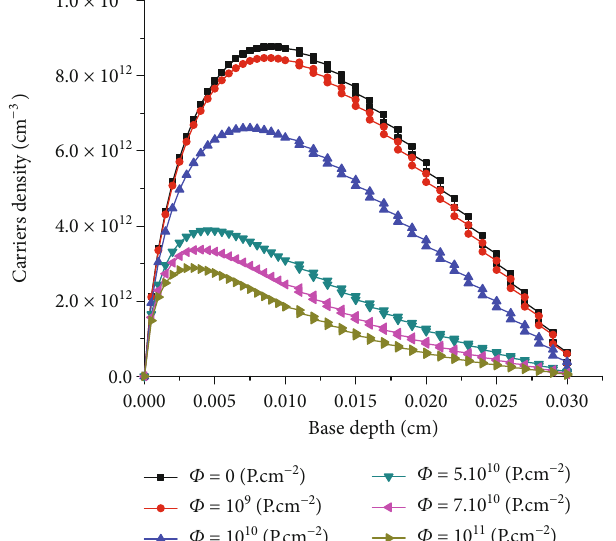
Figure 2: Carrier density versus base depth for di ff erent values of the fl uence ( L 0 = 0 : 02cm ; Sb = 4 : 10 4 cm : s − 1 ; Sf = 8 : 10 8 cm : s − 1 ; D = 27 cm 2 : s − 1 ; H = 0 : 03cm ; Kl = 5 : 6 : 10 − 7 n